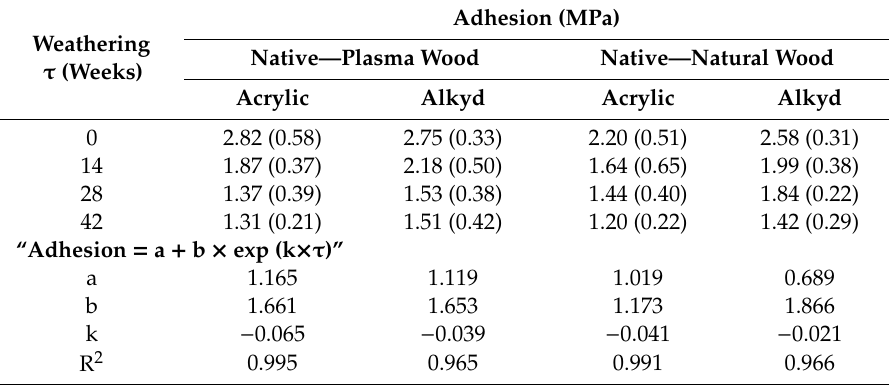
Table 2. The significant negative e ff ects of outdoor weathering on the adhesion strength between the coating (acrylic or alkyd) and the native Norway spruce wood—subjected to or not subjected to plasma modification.